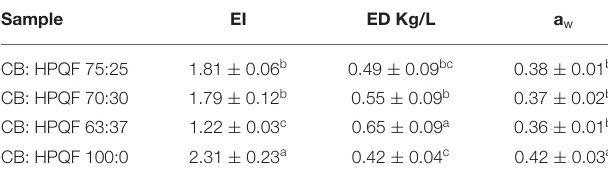
TABLE 3 | Extrusion density (ED) and expansion index